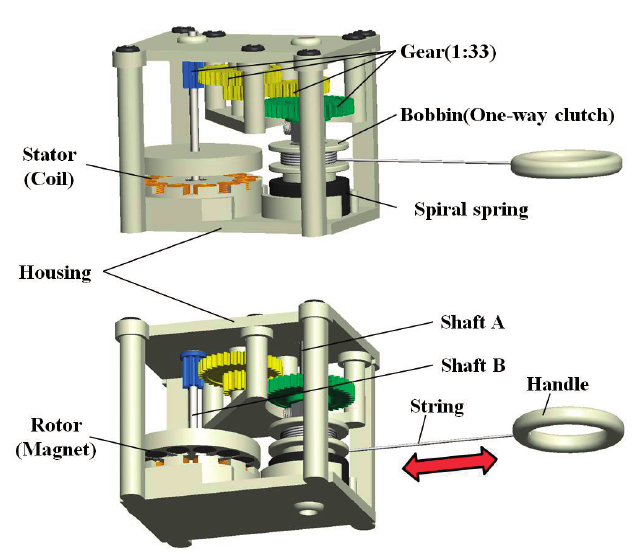
Figure 4. 3-D designed structure of the pulling energy